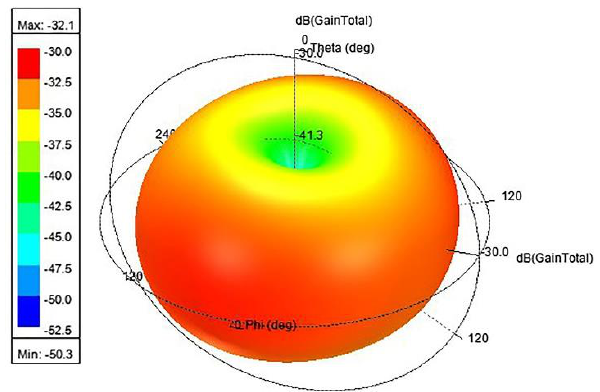
Figure 13. Simulation of the NFP-PCB radiation pattern.